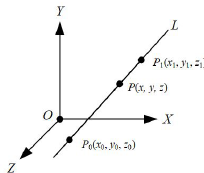
Figure 12. Line L passing through points P 0 ( x 0 , y 0 , z 0 ) and P 1 ( x 1 , y 1 , z 1 ) .